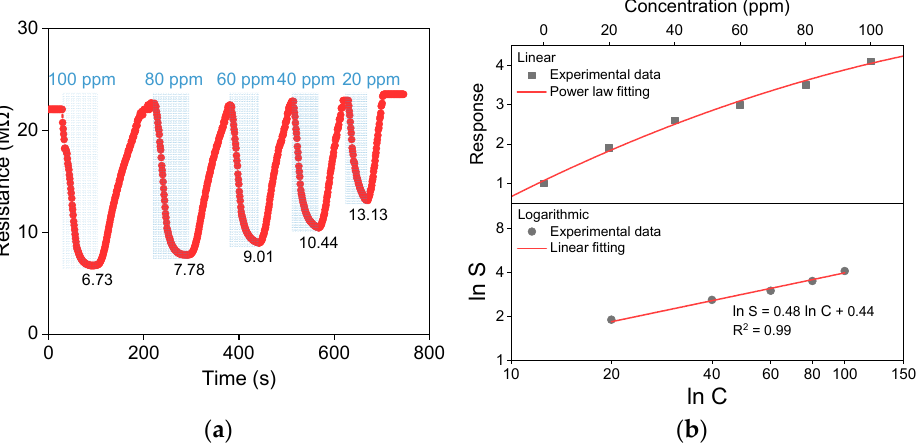
Figure 7. Gas-sensing properties of BP gas sensors deposited at 350 ◦ C for 30 min: ( a ) Dynamic sensor response to various gas concentrations; ( b ) Evaluation of sensor sensitivity.